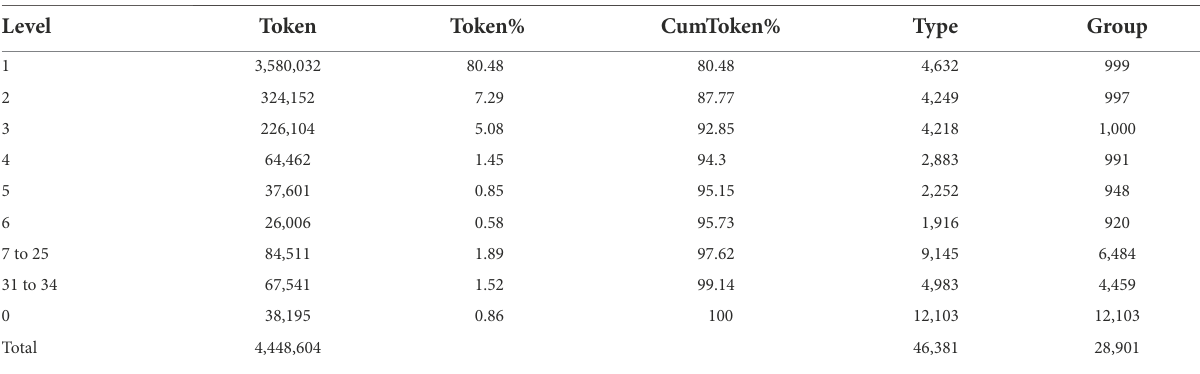
TABLE 1 The lexical profile of MOOC lectures based on BNC/COCA lists.